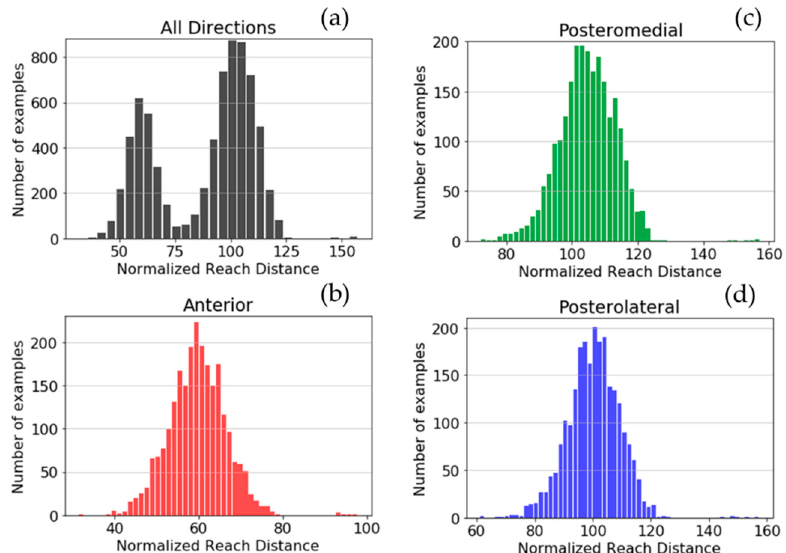
Figure 4. Histograms of YBT excursions depending on the NRD for all directions ( a ), anterior direction ( b ), posteromedial direction ( c ), and posterolateral direction ( d ).